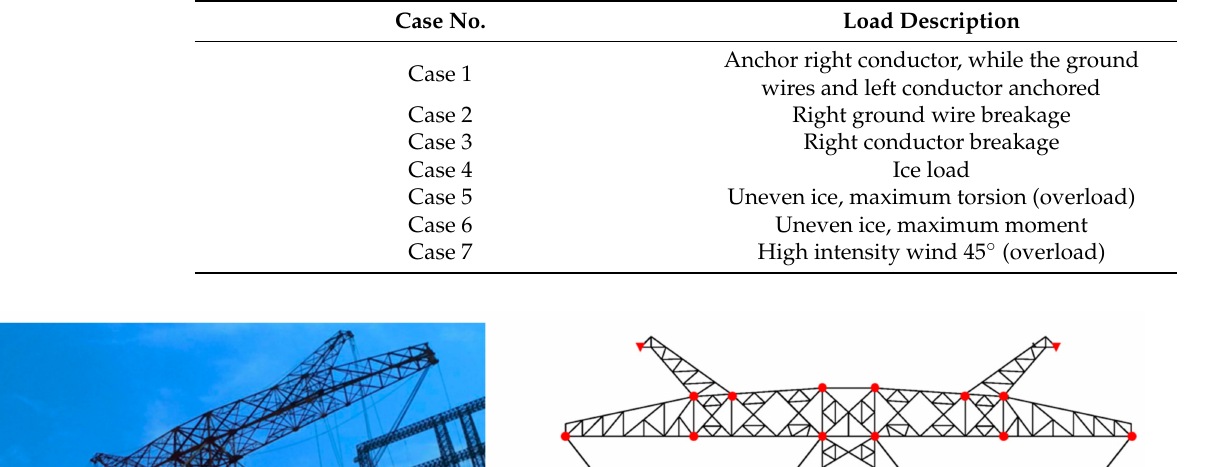
Table 1. Scenarios of the full-scale test.